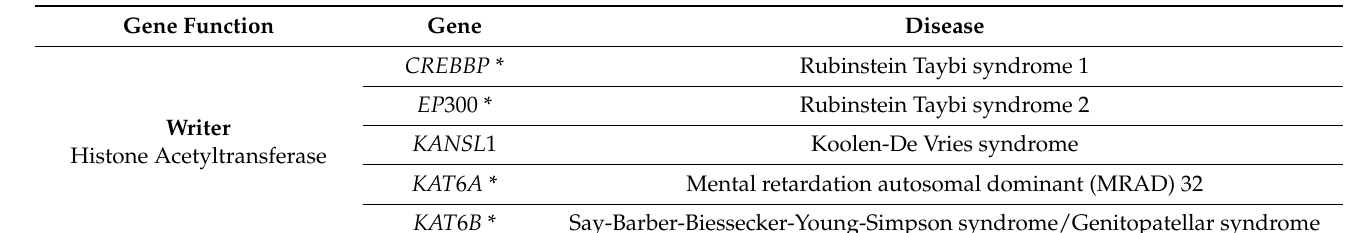
Table 3. Mendelian disorders of the epigenetic machinery. Writer, eraser and remodeler enzymes that also carry a reader domain are marked by an asterisk. Adapted from